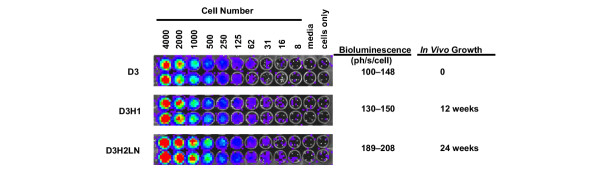
In vitro bioluminescence of MDA-MB-231 sublines D3, D3H1 and D3H2LN. Cells from each subline were serially diluted in duplicate wells from 4000 to 8 cells/well. Luciferin substrate was added to each well and the plate was imaged to obtain photons/s per cell. Wells with media (no cells) or cells alone (no luciferin) were included as controls. The range of bioluminescence for each subline represents data collected from two to three experiments.